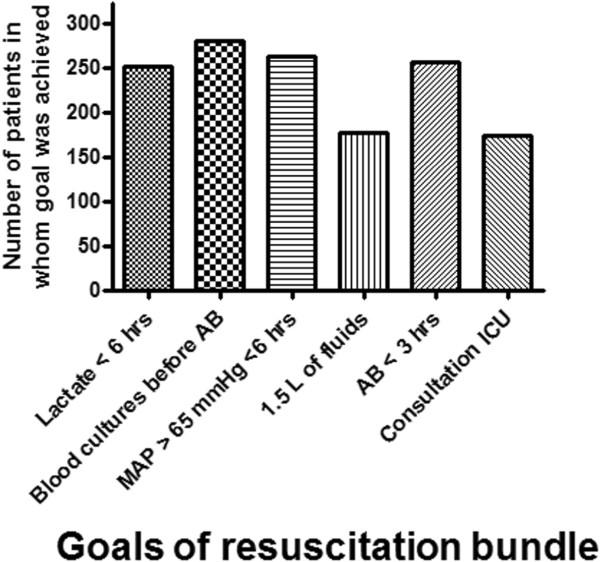
Number of septic ED patients in whom a target of the resuscitation bundle had been achieved. In the Netherlands, the targets of the resuscitation bundle requiring a central venous line are usually done in the ICU. ICU consultation was therefore considered as a goal to be attained in the ED.